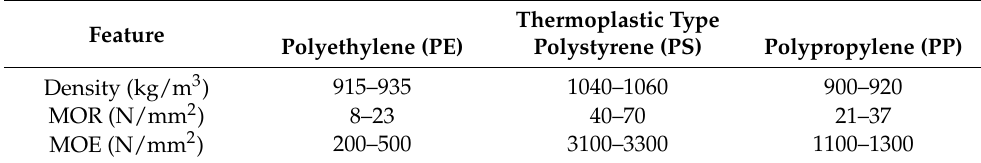
Table 3. General information about the basic mechanical properties of the thermoplastics used [28–30].